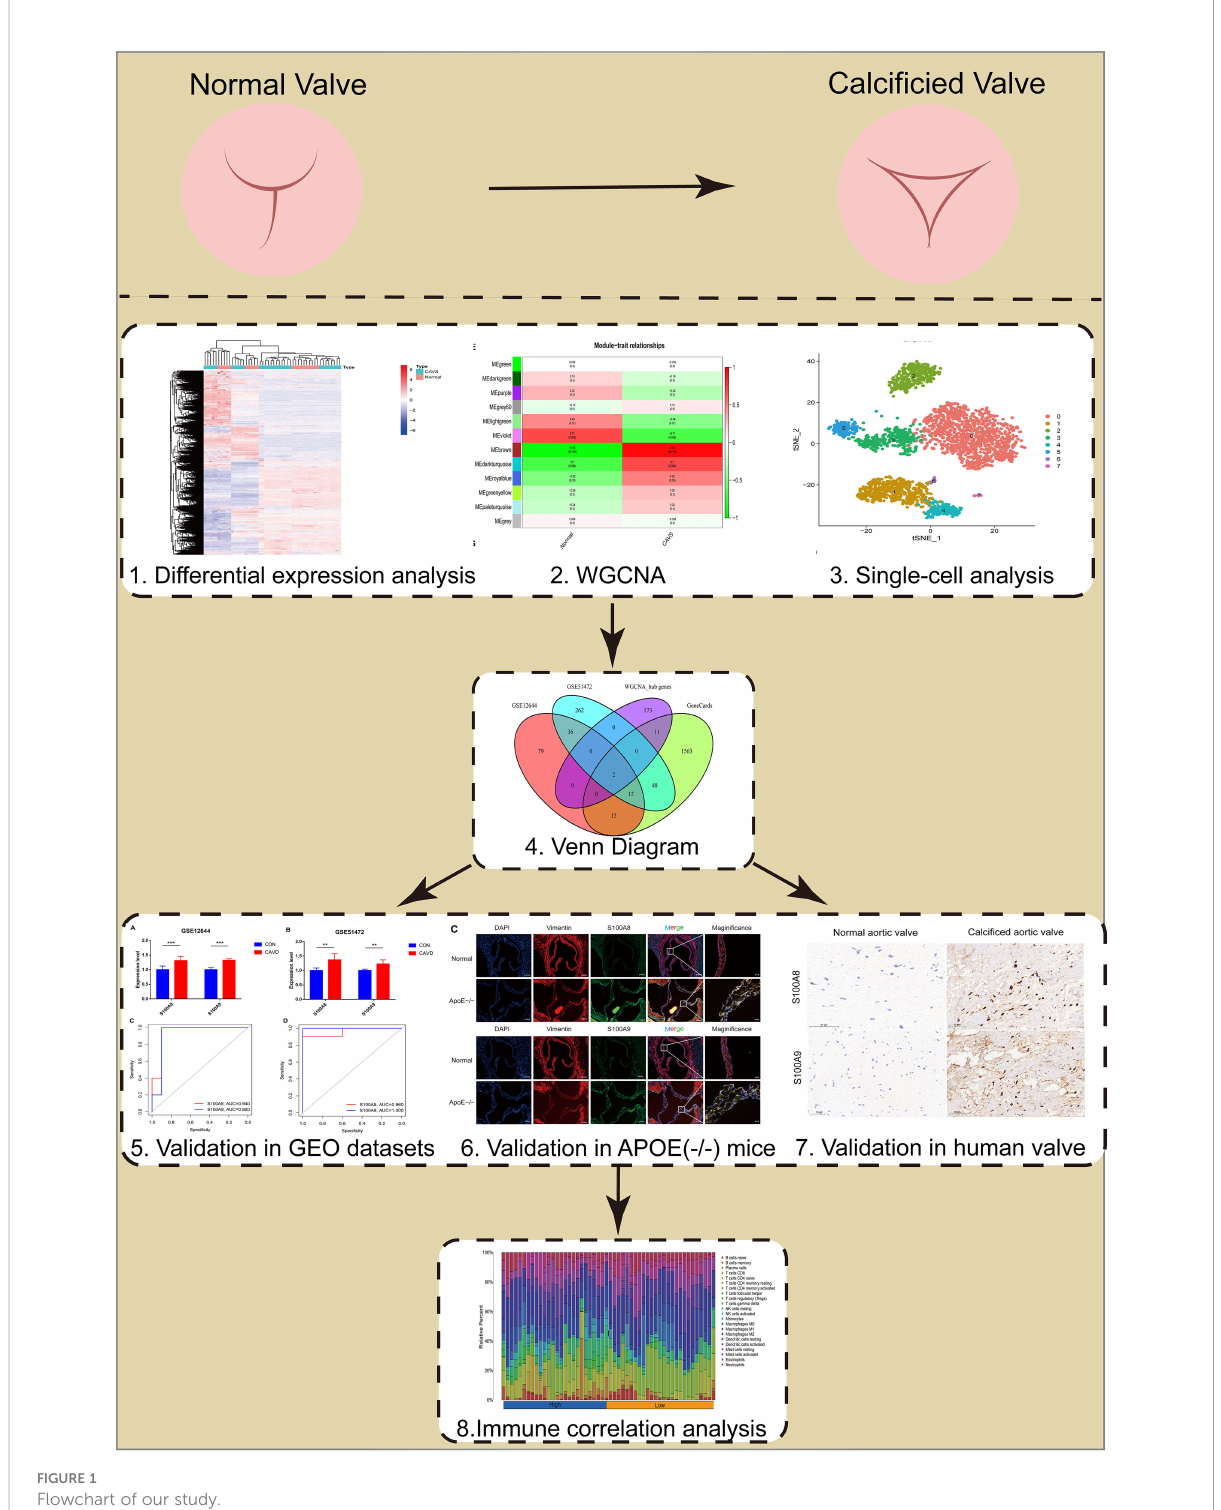
FIGURE 1 Flowchart of our